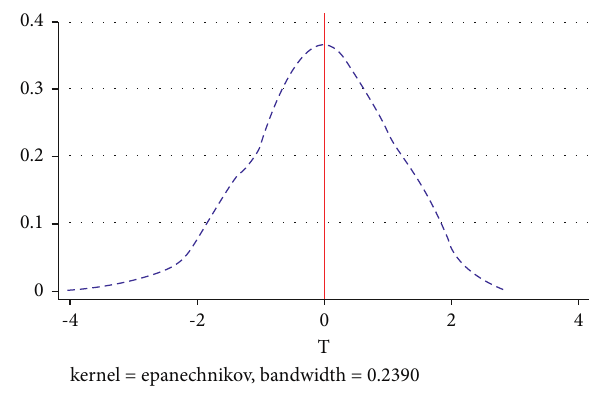
Figure 5: Placebo